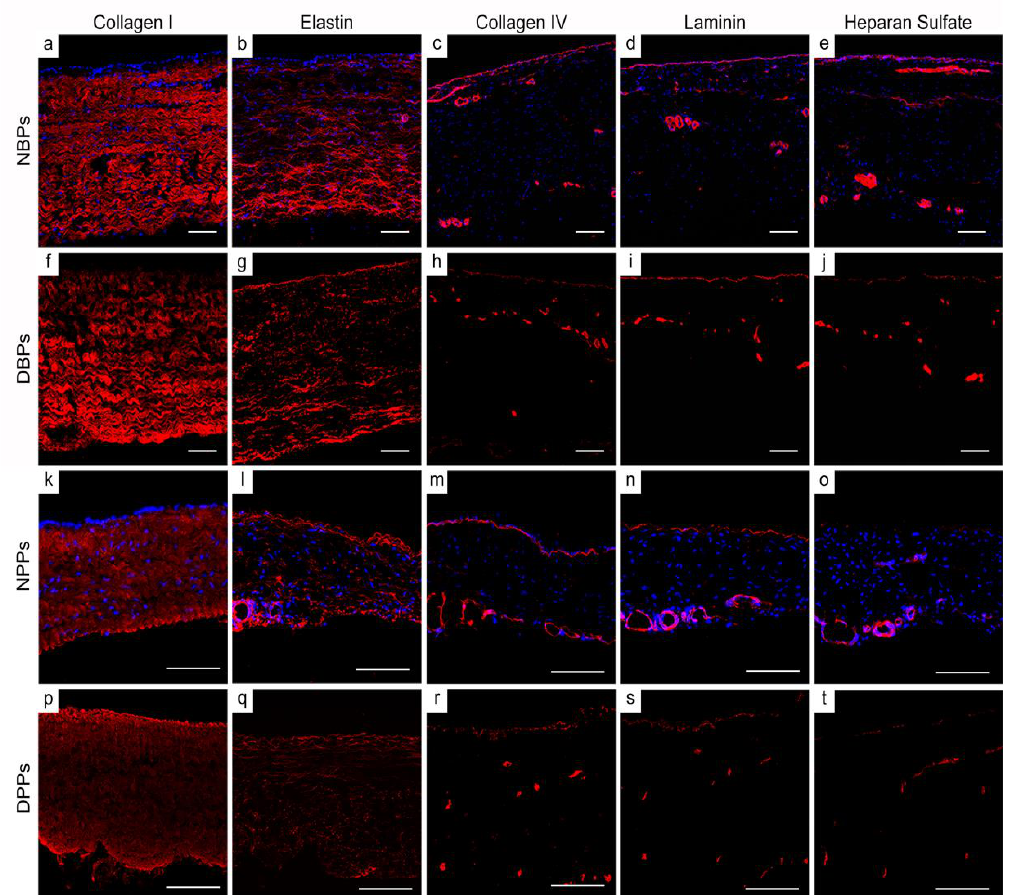
Figure 2. Extracellular matrix (ECM) properties of bovine and porcine pericardia before and after TRICOL decellularization. The general histoarchitecture of collagen and elastin was preserved after TRICOL decellularization (red; f and g for bovine ECM; p and q for porcine ECM) with respect to the native condition (red; a and b for bovine ECM; k and l for porcine ECM). The basal lamina elements, i.e., collagen IV, laminin and heparan sulfate, were not removed in TRICOL-treated tissues (red; h-j for bovine ECM and r-t for porcine ECM) as compared to native samples (red; c-e for bovine ECM and m-o for porcine ECM). Nuclei, clearly visible with DAPI in native tissues (blue; a–e for bovine tissues; k–o for porcine tissues), were absent after decellularization (f–j for bovine sca ff olds; p–t for porcine sca ff olds). Magnification bars: 100 µ m. NBP = Native Bovine Pericardium, DBP = Decellularized Bovine Pericardium, NPP = Native Porcine Pericardium, and DPP = Decellularized Porcine Pericardium.